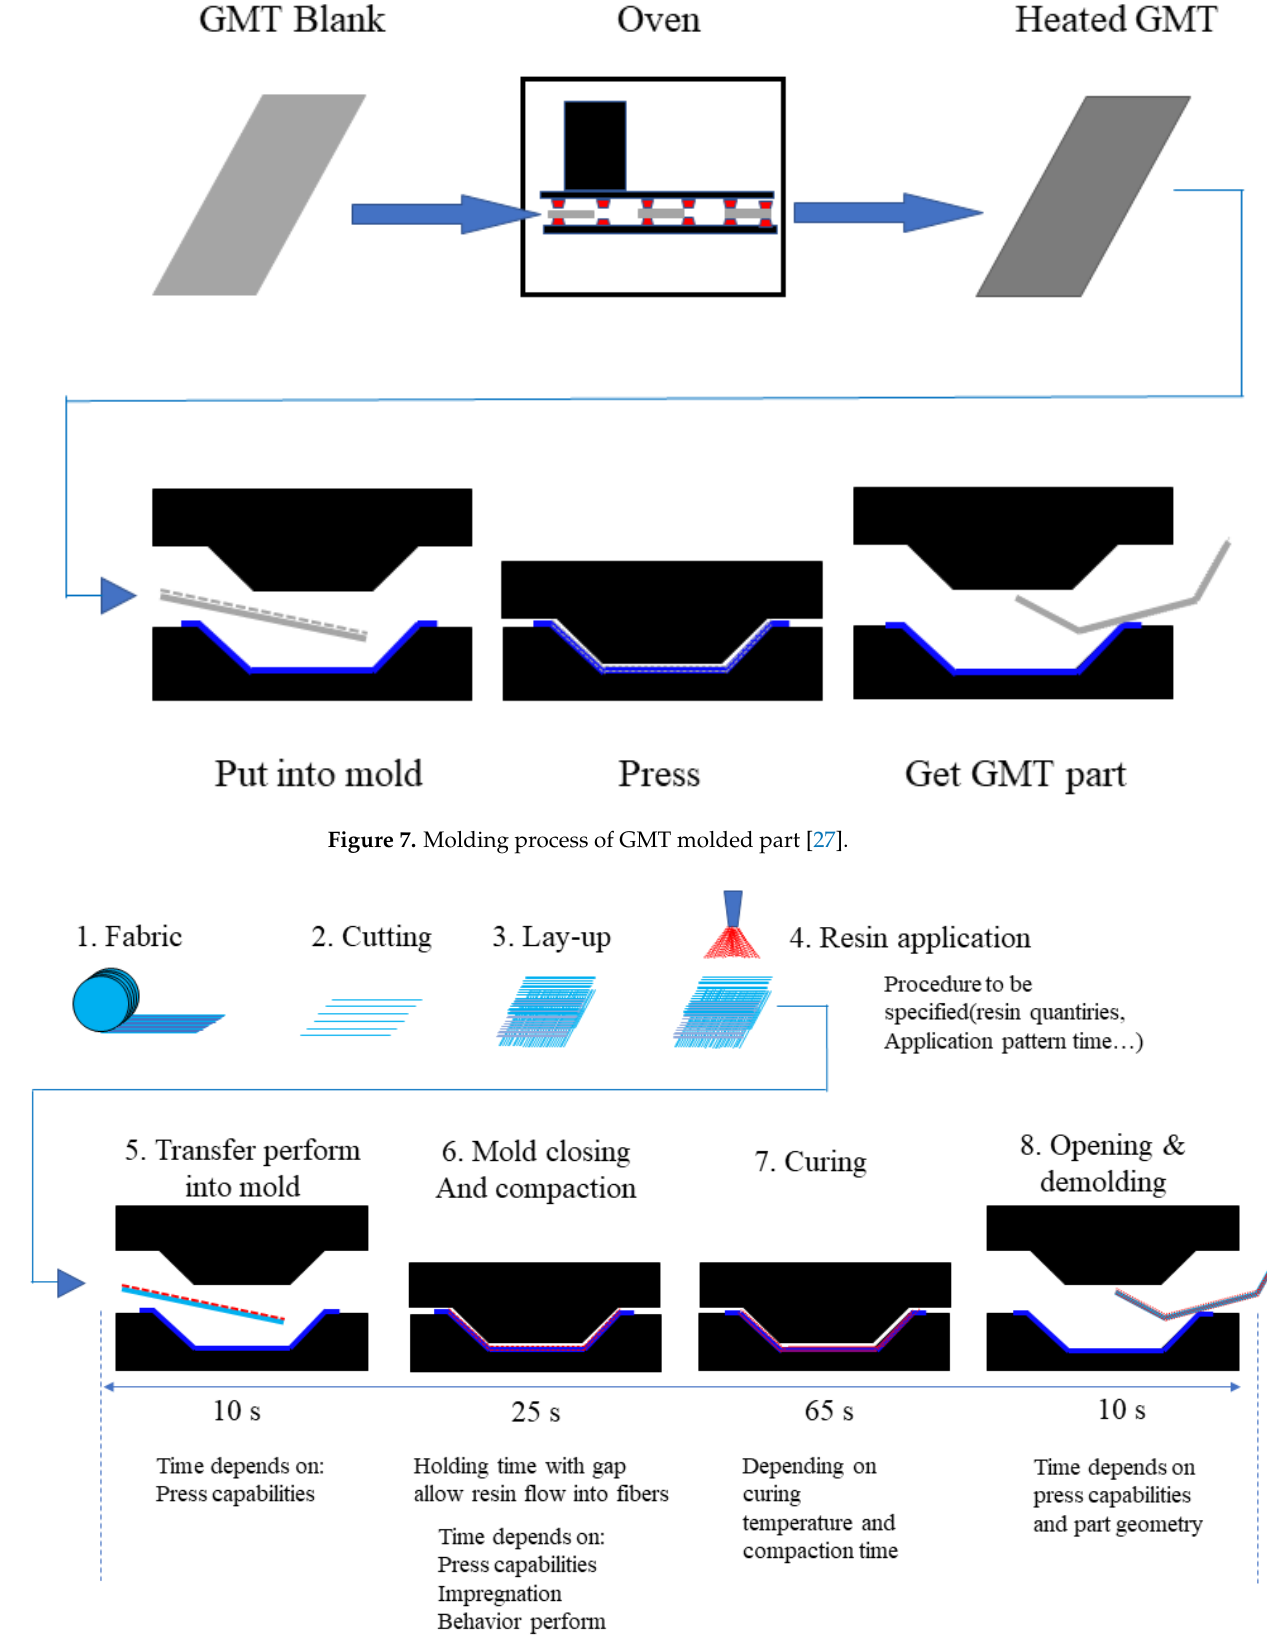
Figure 8. Wet molding process (MOMENTIVE, USA) [27].